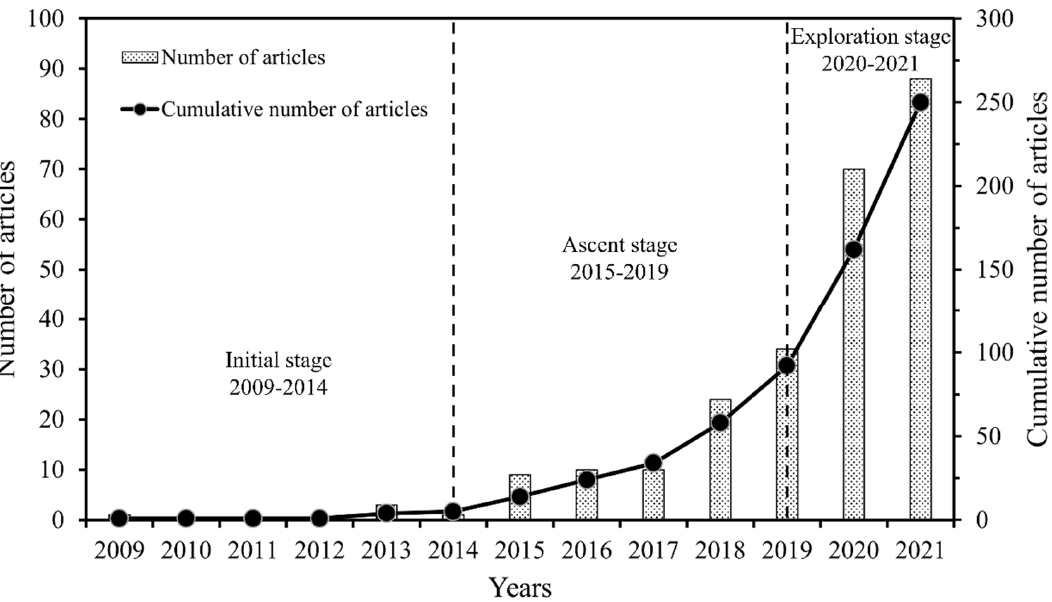
Figure 1. Annual and cumulative number of publications on microplastics in coastal agglomerations from January 2009 to December 2021.